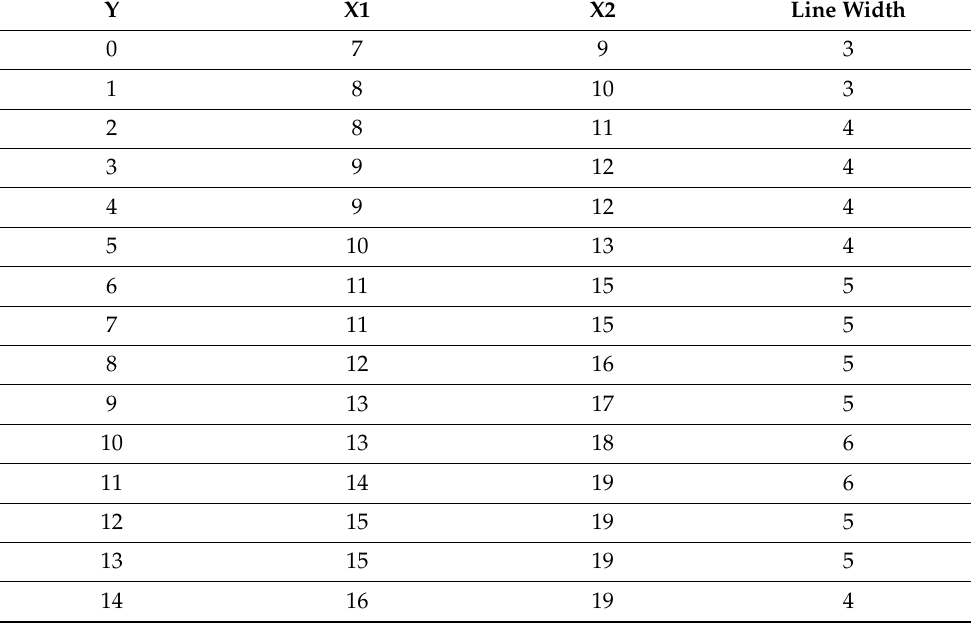
Table 1. Line text structure.